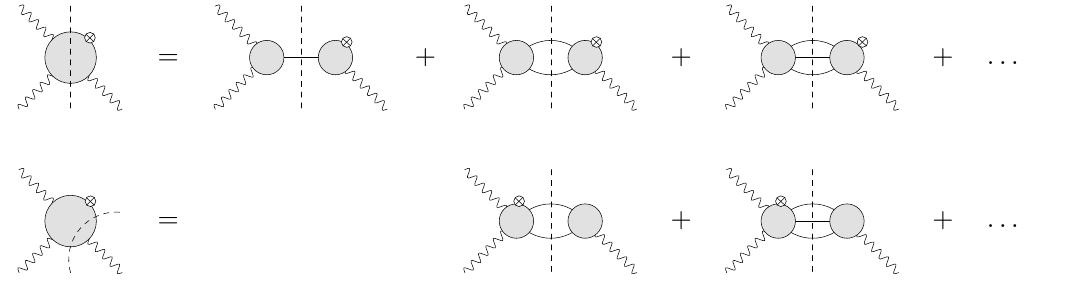
-channel discon- 3